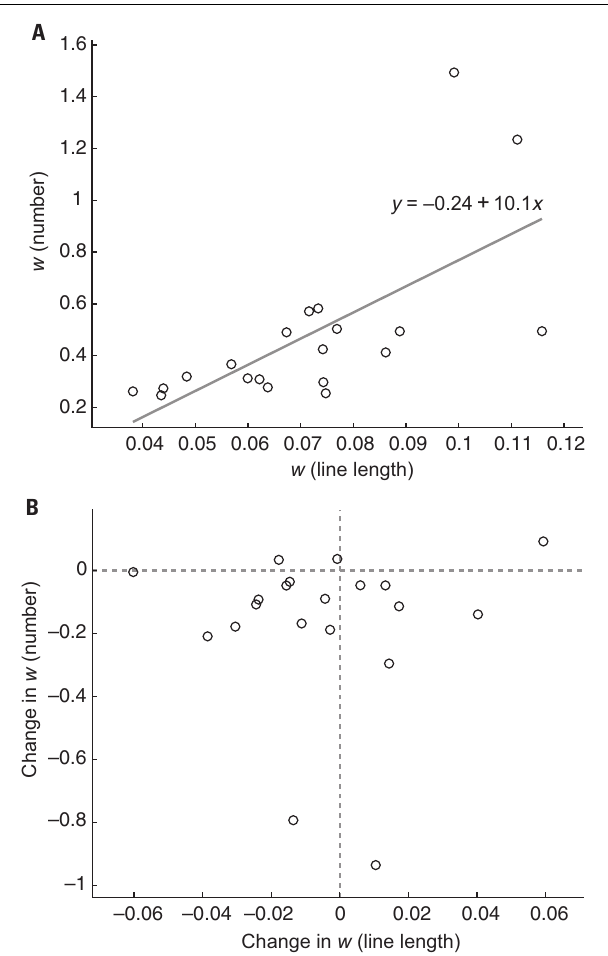
FIGURE 7 | (A) Standardized mathematics test scores (GRE or SAT) were negatively correlated with w ( r 2 = 0.28, p < 0.02). Gray line is the best fit to the data and the equation shows the intercept and slope. (B) Verbal scores were not significantly correlated with w ( r 2 = 0.08, p =